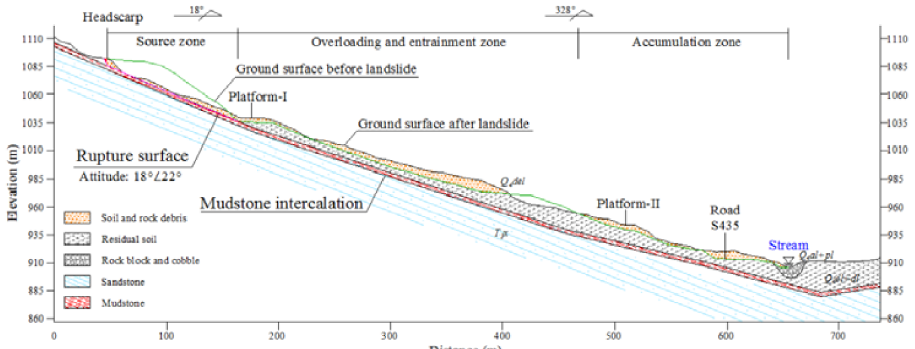
Figure 3. Cross-section of the ZHC landslide (1-1 (cid:48) in Figure